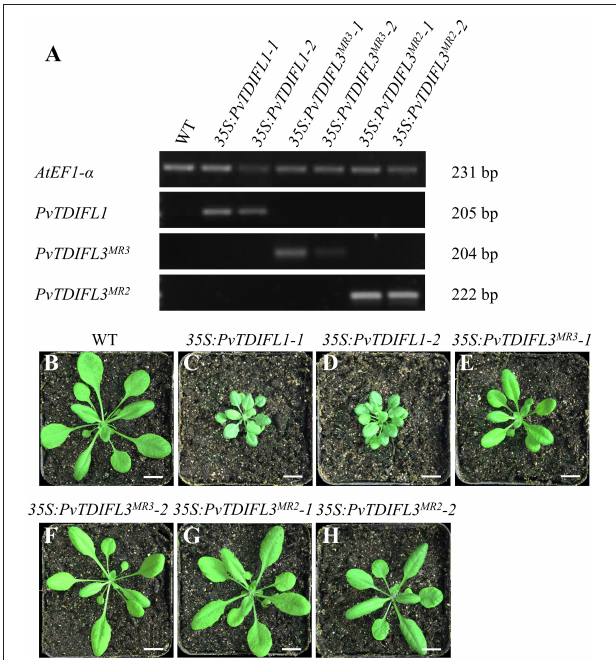
FIGURE 5 | Reverse Transcription PCR (RT-PCR) analysis and morphology of 4-week-old Arabidopsis seedlings expressing PvTDIFL s. (A) RT-PCR analysis of 35S:PvTDIFL lines used in this study. AtEF1- α was used as the reference gene. (B) 4-week-old wild type plant. (C–H) 4-week-old transgenic plants harboring 35S:PvTDIFL1-1 (C) , 35S:PvTDIFL1-2 (D) , 35S:PvTDIFL3 MR 3 -1 (E) , 35S:PvTDIFL3 MR 3 -2 (F) , 35S:PvTDIFL3 MR 2 -1 (G) , and 35S:PvTDIFL3 MR 2 -2 (H) transgenes grown in soil. Bar = 1cm in (B–H)